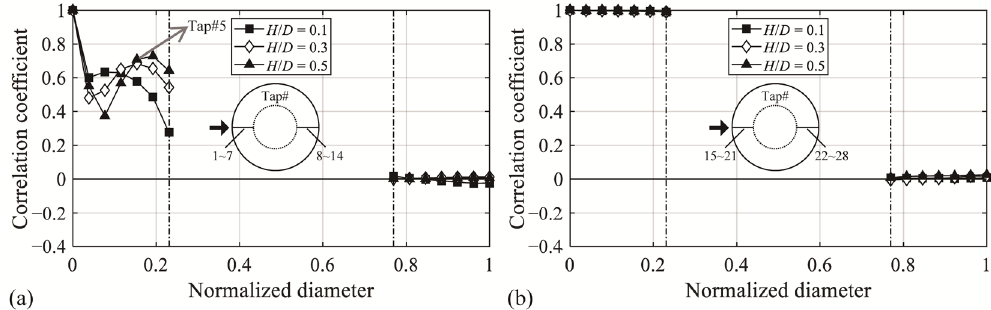
Figure 6. Cross-correlation coefficients of the pressure fluctuations: ( a ) external cross-correlation coefficient and ( b ) internal cross-correlation coefficient.